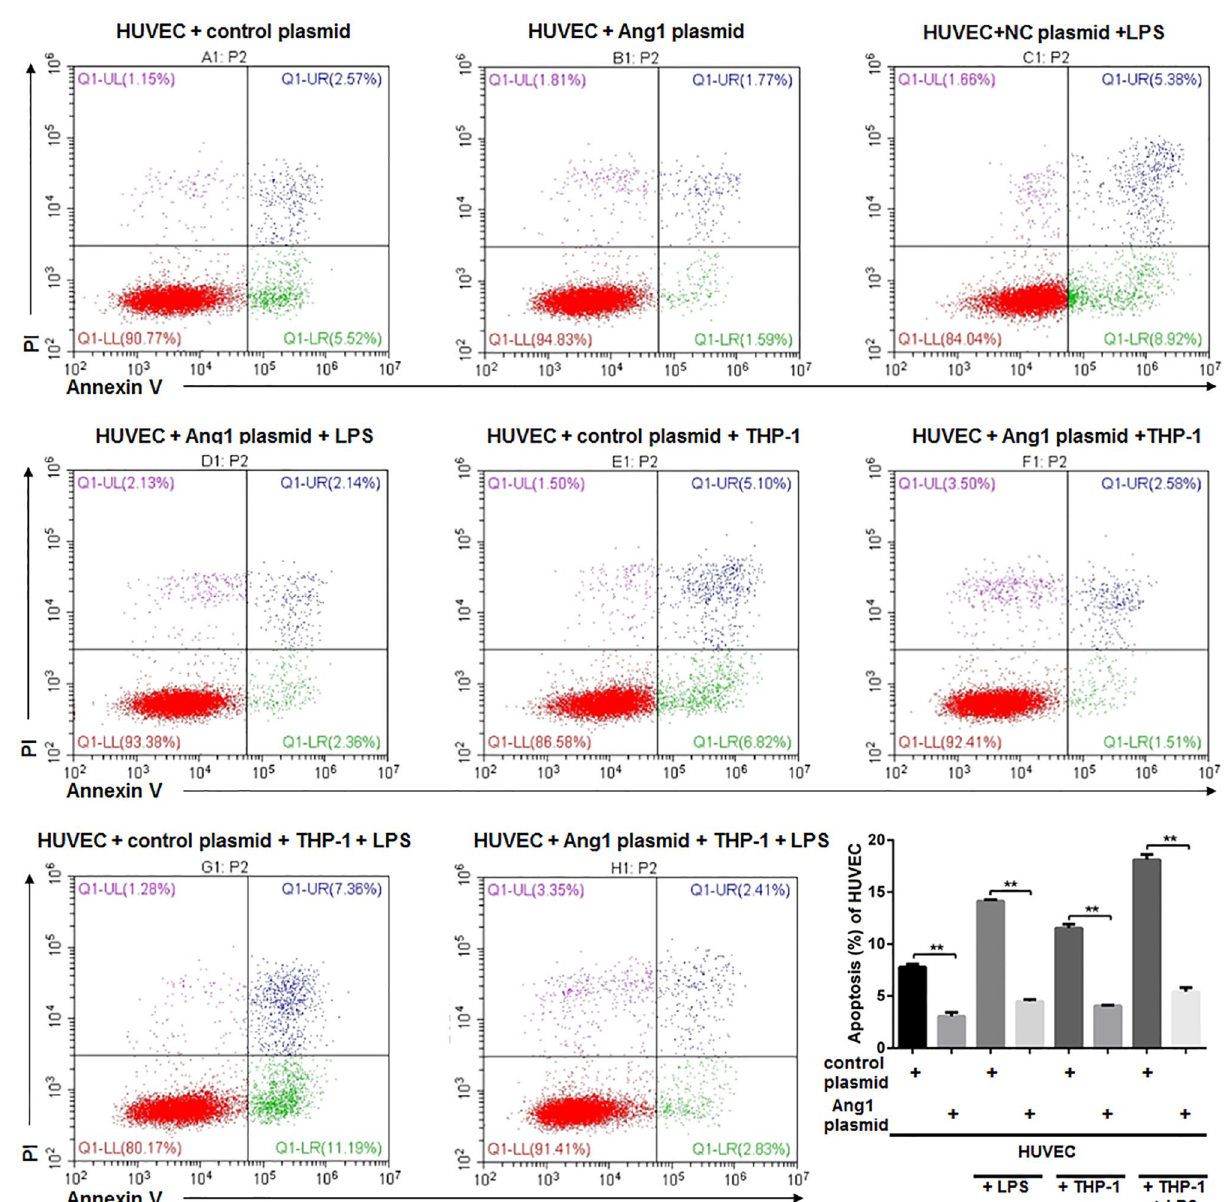
Figure 6. Forced expression of Ang1 significantly attenuated apoptosis of HUVECs under various conditions. HUVECs were transfected with Ang1-expressing plasmid or control plasmid for 24 h; and then the HUVECs were cultured alone with/without LPS (100 μg/mL) for 8 h, or co-cultured with THP-1-derived macrophages with/without LPS (100 μg/mL) for 8 h. Apoptosis of HUVECs was quantitated by Annexin V and PI staining via flow cytometry. Annexin V + cells are considered as apoptotic cells. n = 3 for each group. Data are expressed as mean ±